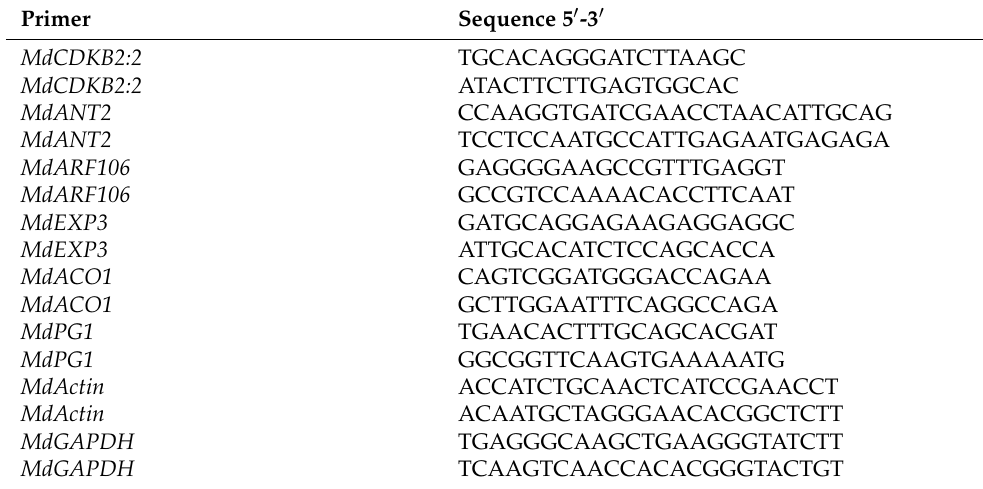
Table 1. Primer sequences for qPCR